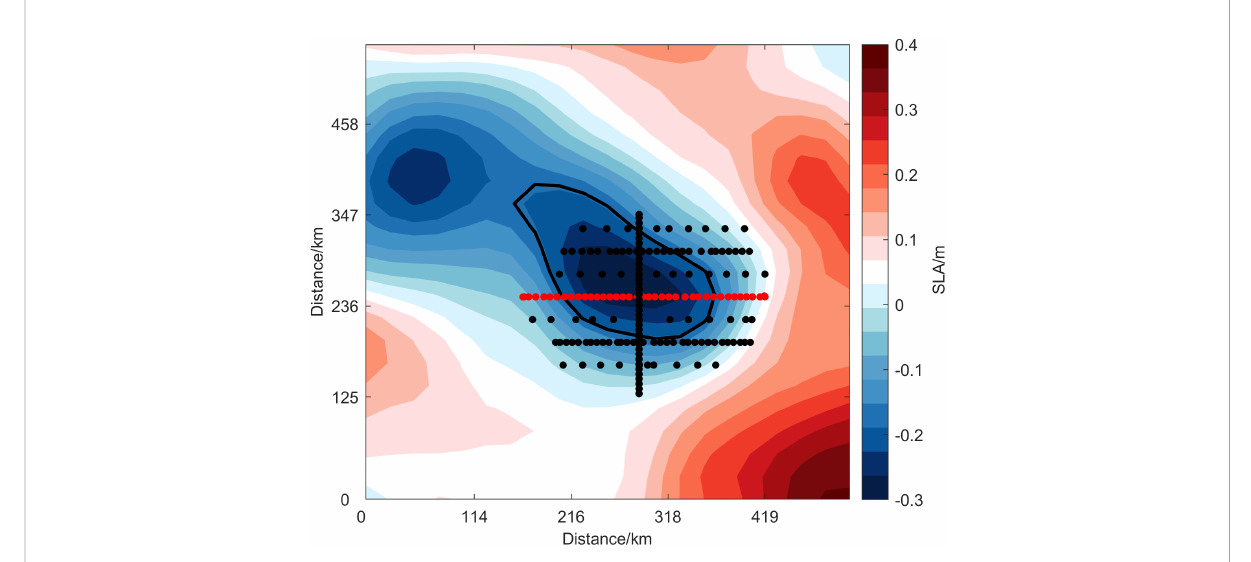
FIGURE 10 The distribution of survey stations of the Northwest Paci fi c cyclone eddy from November 13 to 15, 2019. The red dots represent the location of the study section, the color represents the sea surface level anomaly, and the circle in the fi gure is the mesoscale eddy identi fi ed by satellite SLA.